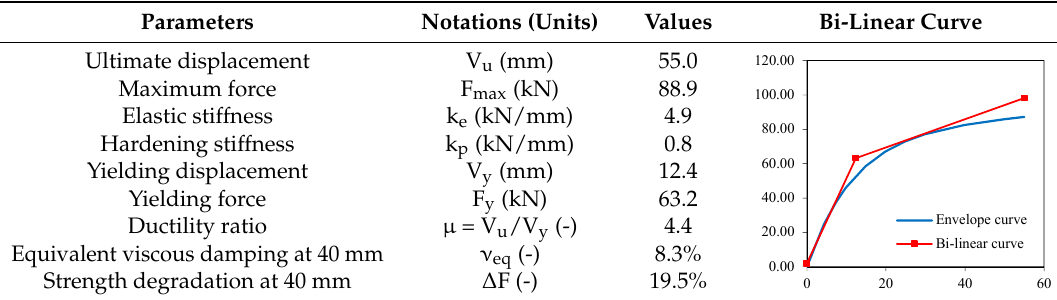
Table 3. Test results and interpretation according to EN 12512 method [17].